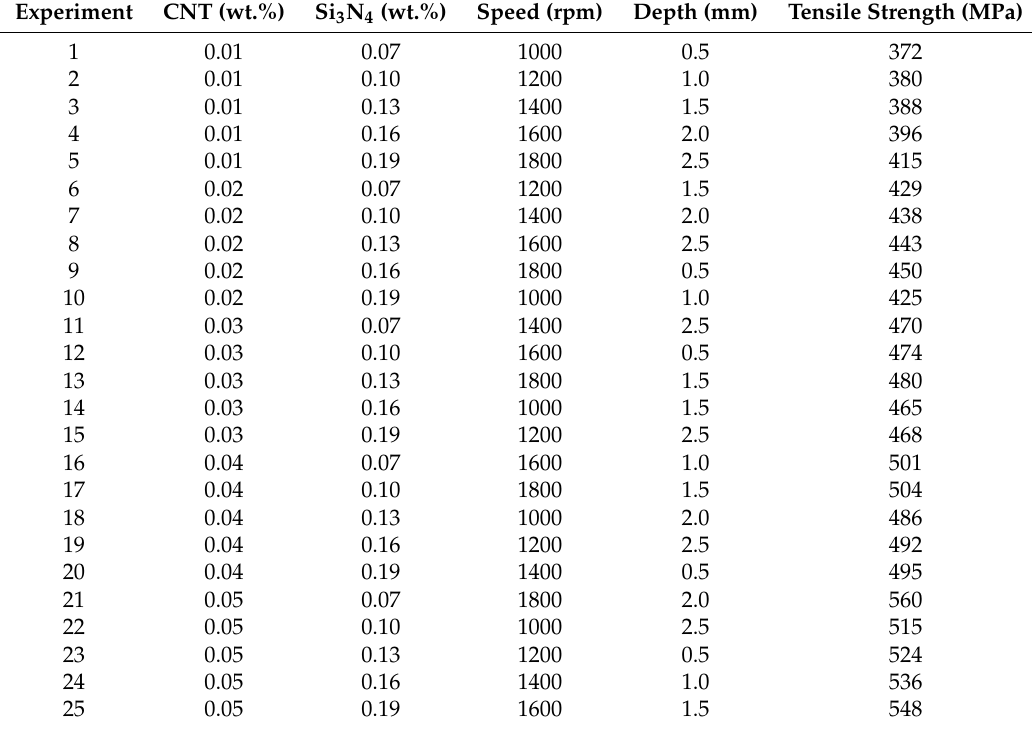
Table 2. Design of experiments as per the Taguchi L 25 orthogonal array. CNT—carbon nanotube. Experiment